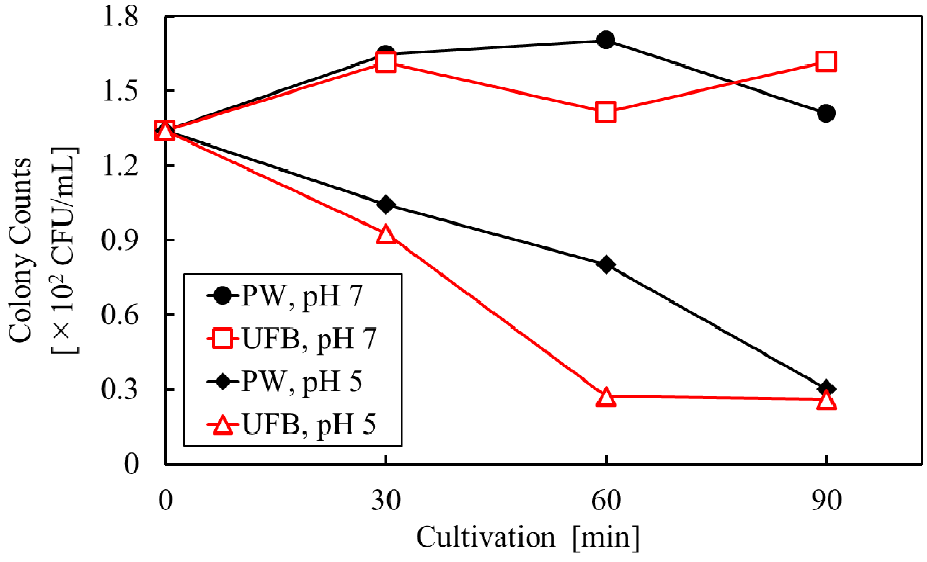
Figure 4. Colony count versus cultivation time in E. coli suspensions subjected to different pH lev- els.